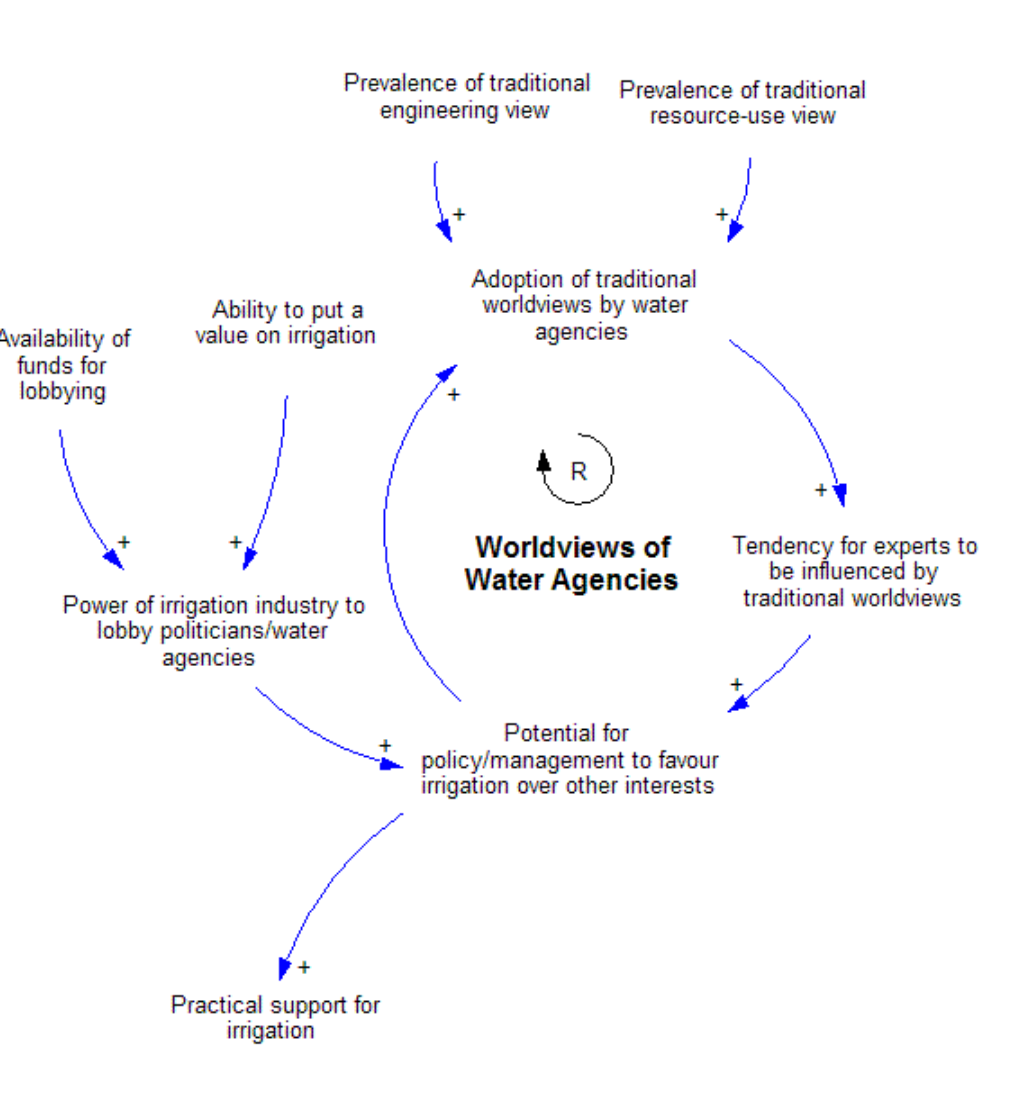
Fig. 5. World views of water agencies. The reinforcing causal loop (R) illustrates some of the effects of the traditional engineering view and the traditional resource-use view prevalent in water agencies. Combined with the lobbying power of the irrigation industry, the world views of the water agency increase the potential for policy and/or management to favor irrigation over other